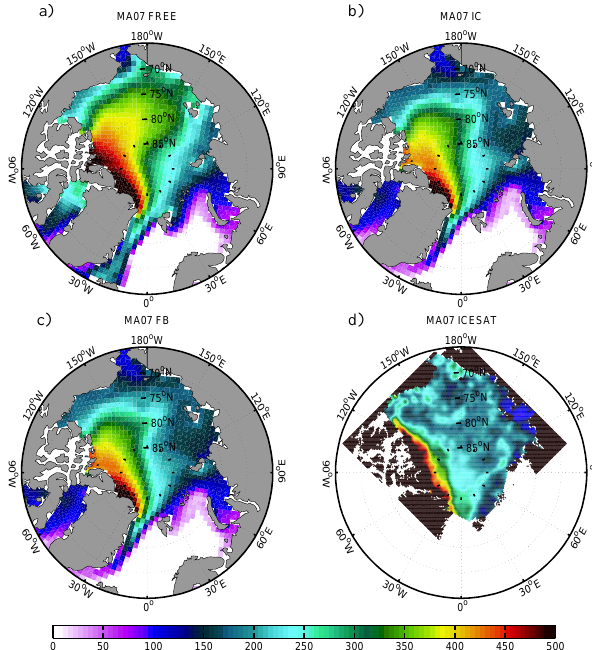
Fig. 6. Sea-ice thickness differences at the 2007 maximum (a, b) and minimum (c, d) sea-ice extent in Arctic. Colors show the sea- ice thickness differences between FB and IC (b, d) and between IC and FREE (a, c) .